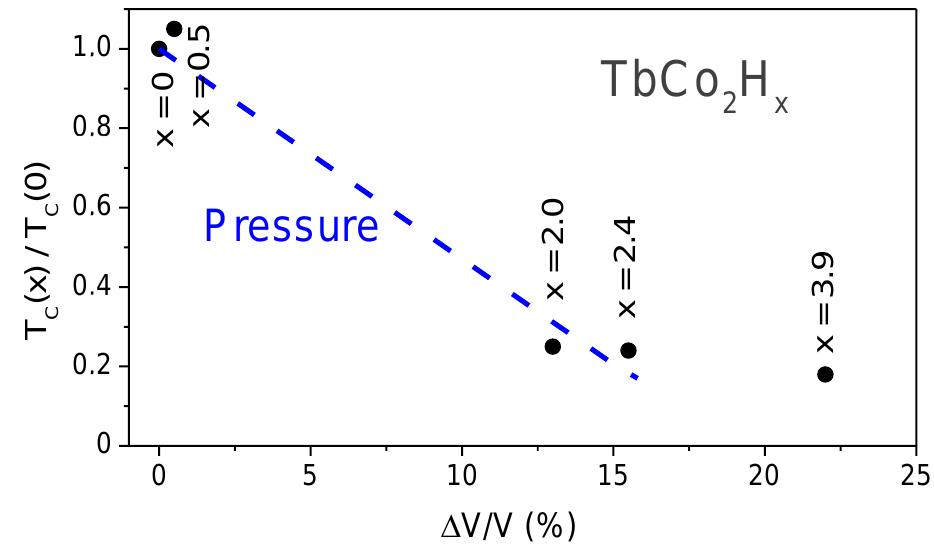
Figure 3. Curie temperature dependence on the relative increase in unit cell volume Δ V/V for the TbCo 2 —H system and the expected change in T C (dashed line), determined on the basis of literature data on the effect of hydrostatic pressure on the Curie temperature [30,38,39]. The magnitude of the magnetocaloric effect in TbCo 2 H 2.4 was calculated from the experimentally obtained magnetization isotherms M ( B ) by an indirect method [1]. The temperature dependences of the change in the magnetic part of the entropy in various magnetic fields (from 1 to 14 T) are shown in Figure 4a.